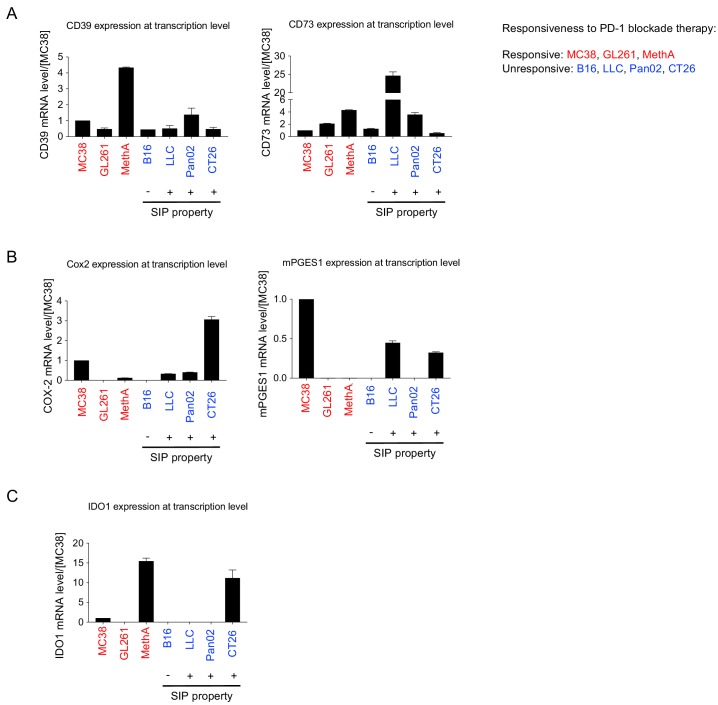
Previously reported factors are not related with the nature of SIP- positive tumors.Expression levels of immune suppression-associated genes were examined by quantitative reverse transcription PCR (qRT-PCR) in different tumor cell lines. Tumor names in red and blue are responsive and unresponsive, respectively. (A) Expression of CD39 (left) and CD73 (right) were quantified. (B) Expression of Cox2 (left) and mPGES1 (right) were quantified. (C) Expression of IDO1 was quantified. Data represent the means ± SEM of 3 wells assuming the expression in MC38 = 1 in qRT-PCR analysis. Data are representative of 3 independent experiments. Murine b -actin was taken as internal control during qRT-PCR analysis.